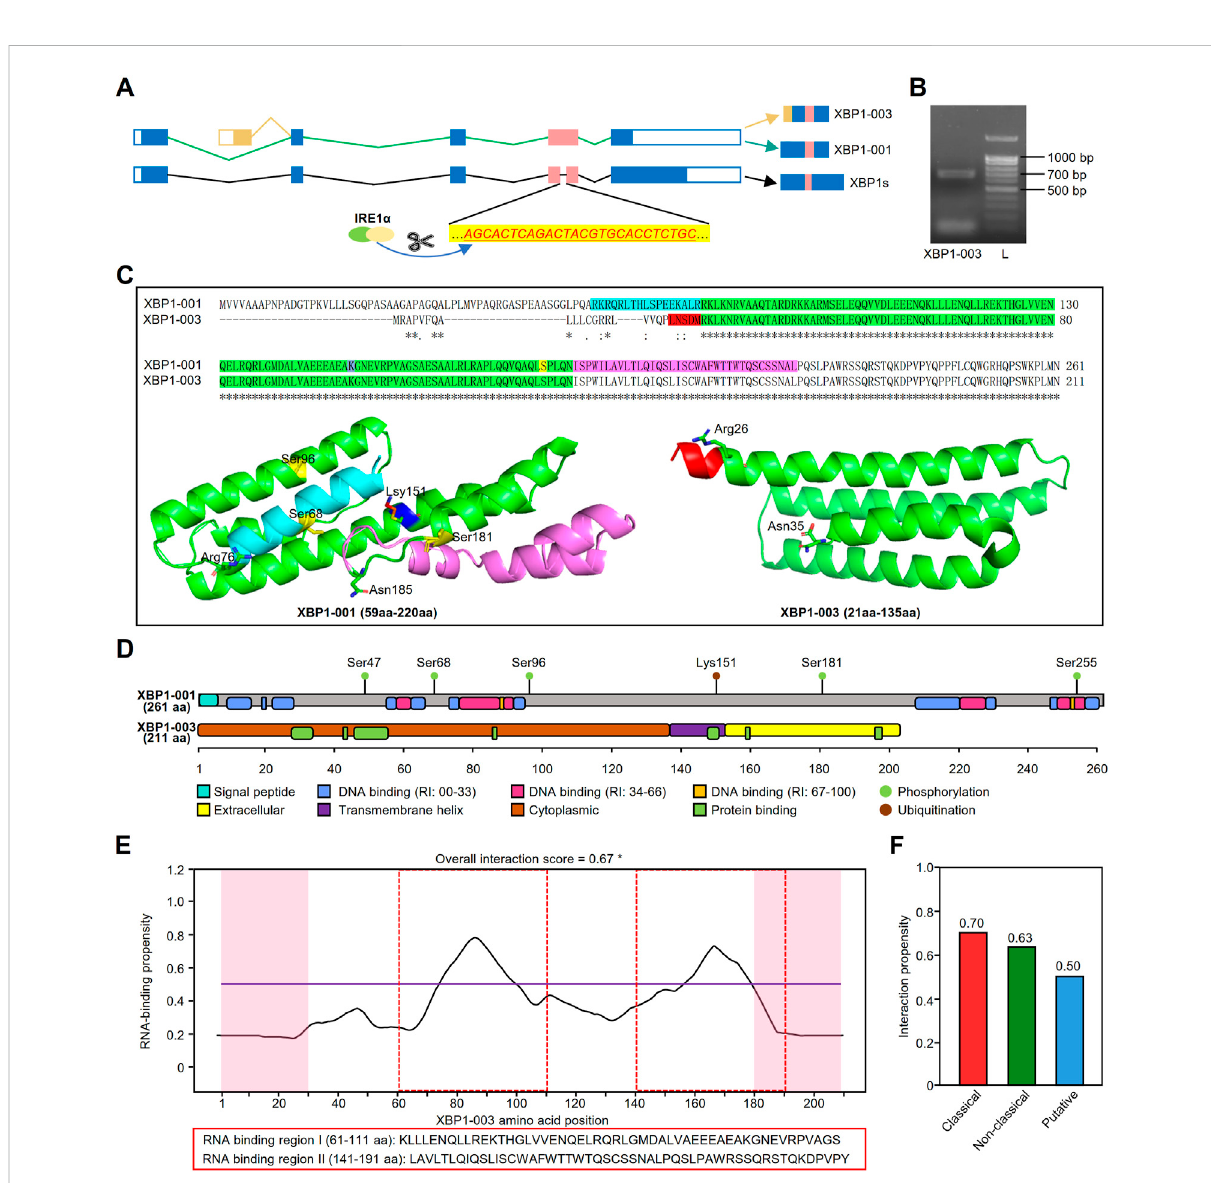
FIGURE 8 Structural and functional prediction of XBP1 isoforms. (A) The schematic of XBP1 pre-mRNA where the small intron (26 nt) recognized and excised by IRE1 α in red. (B) Gel electrophoresis showed that the ampli fi cation products from MM.1S. L, ladder. (C) Pairwise alignment of amino acid sequencesofXBP1-001(ID:P17861)andXBP1-003(ID:B1AHH1)inUniProtdatabaseandthreedimensionalstructureofXBP1-001(59aa-220aa)and XBP1-003 (21aa-135aa) protein fragments. The protein data with PDB IDs 5a7dL and 2yfaA were downloaded from the ModBase. (D) The schematic diagram of protein domains and post-translational modi fi cation sites of XBP1-001 and XBP1-003. Speci fi c domains are shown in distinct colors. The protein domains were predicted with PredictProtein, and information of phosphorylation/ubiquitination was collected from the cBioPortal. (E) Prediction of RNA binding-sites of XBP1-001 protein by catRAPID. *: prediction score > 0.5. (F) Interaction propensity scores for the RNA binding-sites of XBP1-003 derived from three independent methods in